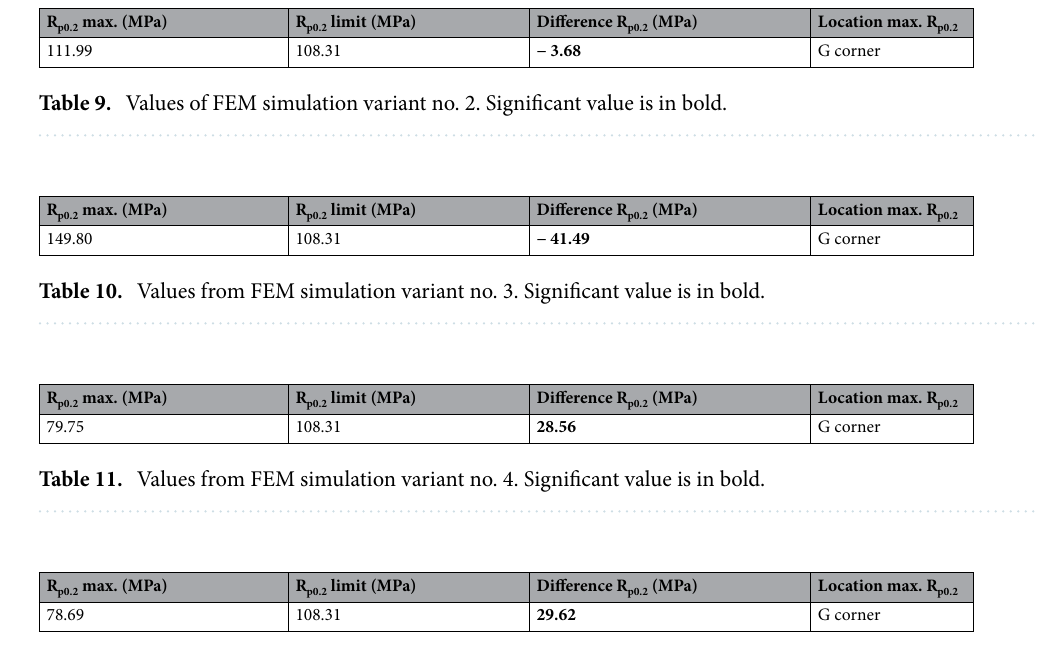
Table 12. Values from FEM simulation variant no. 5. Significant value is in bold.